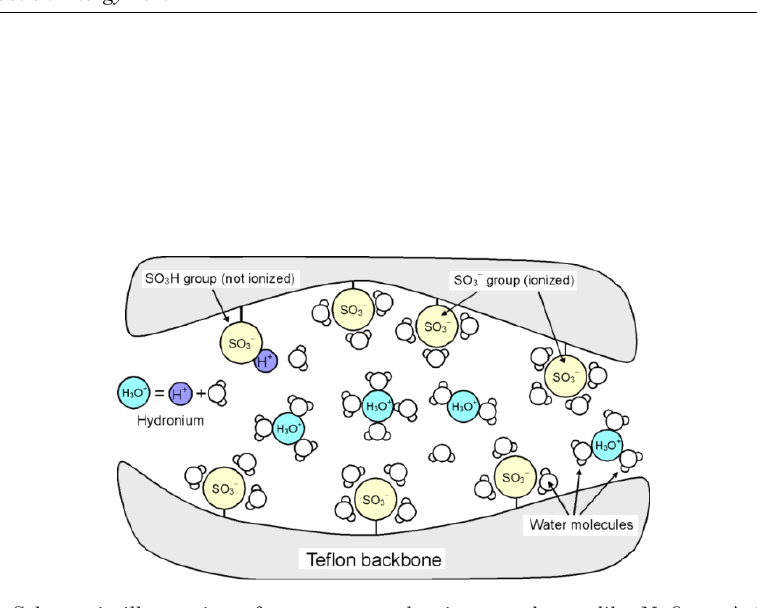
Fig. 13. – Schematic illustration of a proton conducting membrane like Nafion. A fluorinated carbon backbone offers high chemical stability while sulfonate groups that can easily be proto- nated and deprotonated ensure high ion conductivity. Figure from [57] under Creative Commons Attribution